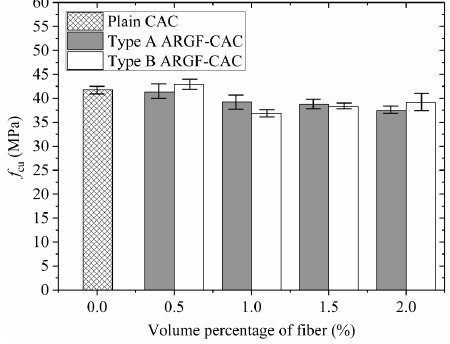
Figure 10. Variation f cu with fiber content.